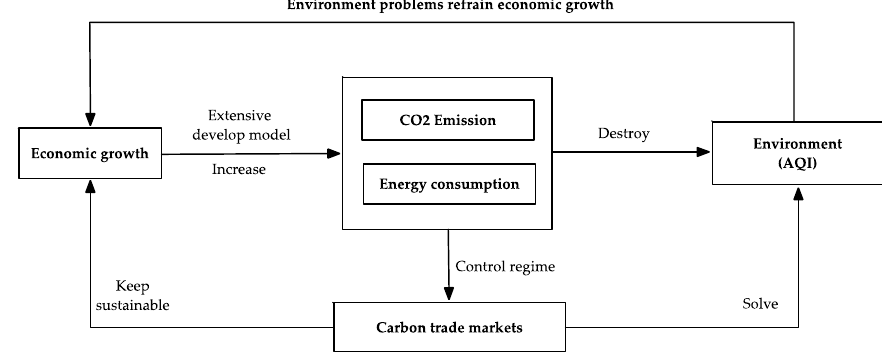
Figure 1. Relationship diagram of economic growth, carbon trade market, and environment.